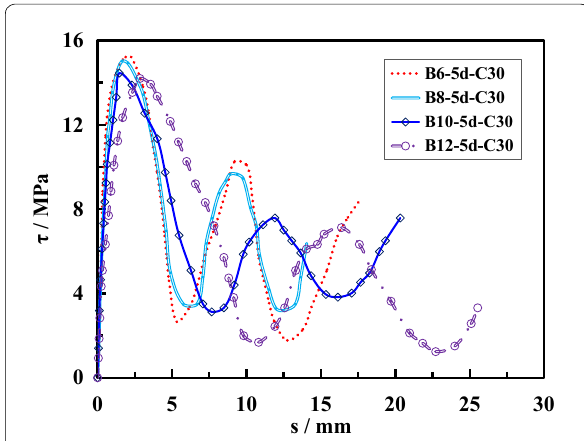
Fig. 9 τ - s curves of specimens with different diameters.